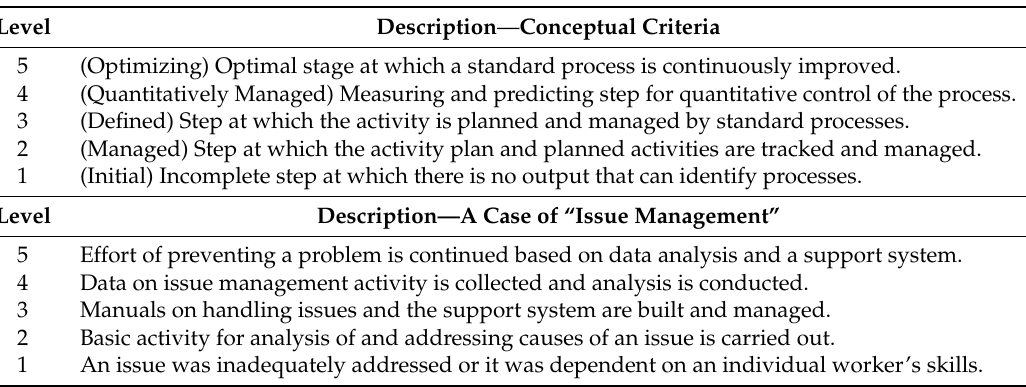
Table 2. Maturity based rating